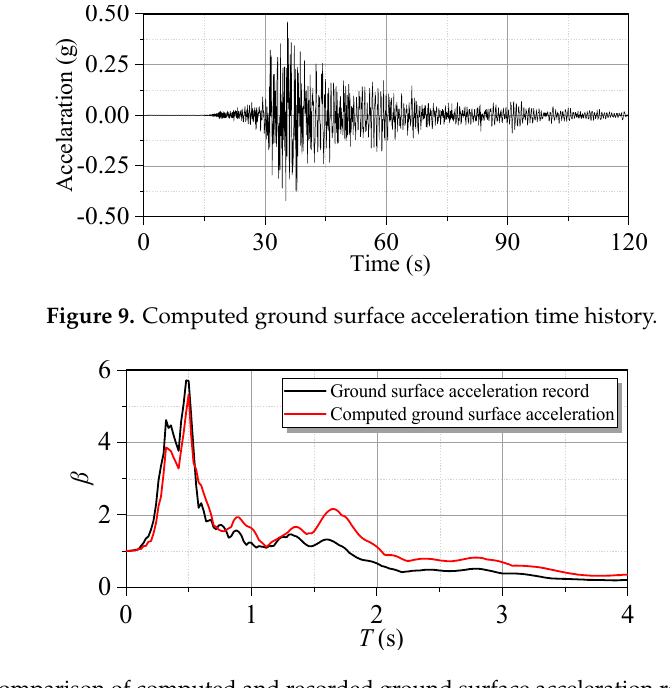
Figure 10. Comparison of computed and recorded ground surface acceleration response spectra.